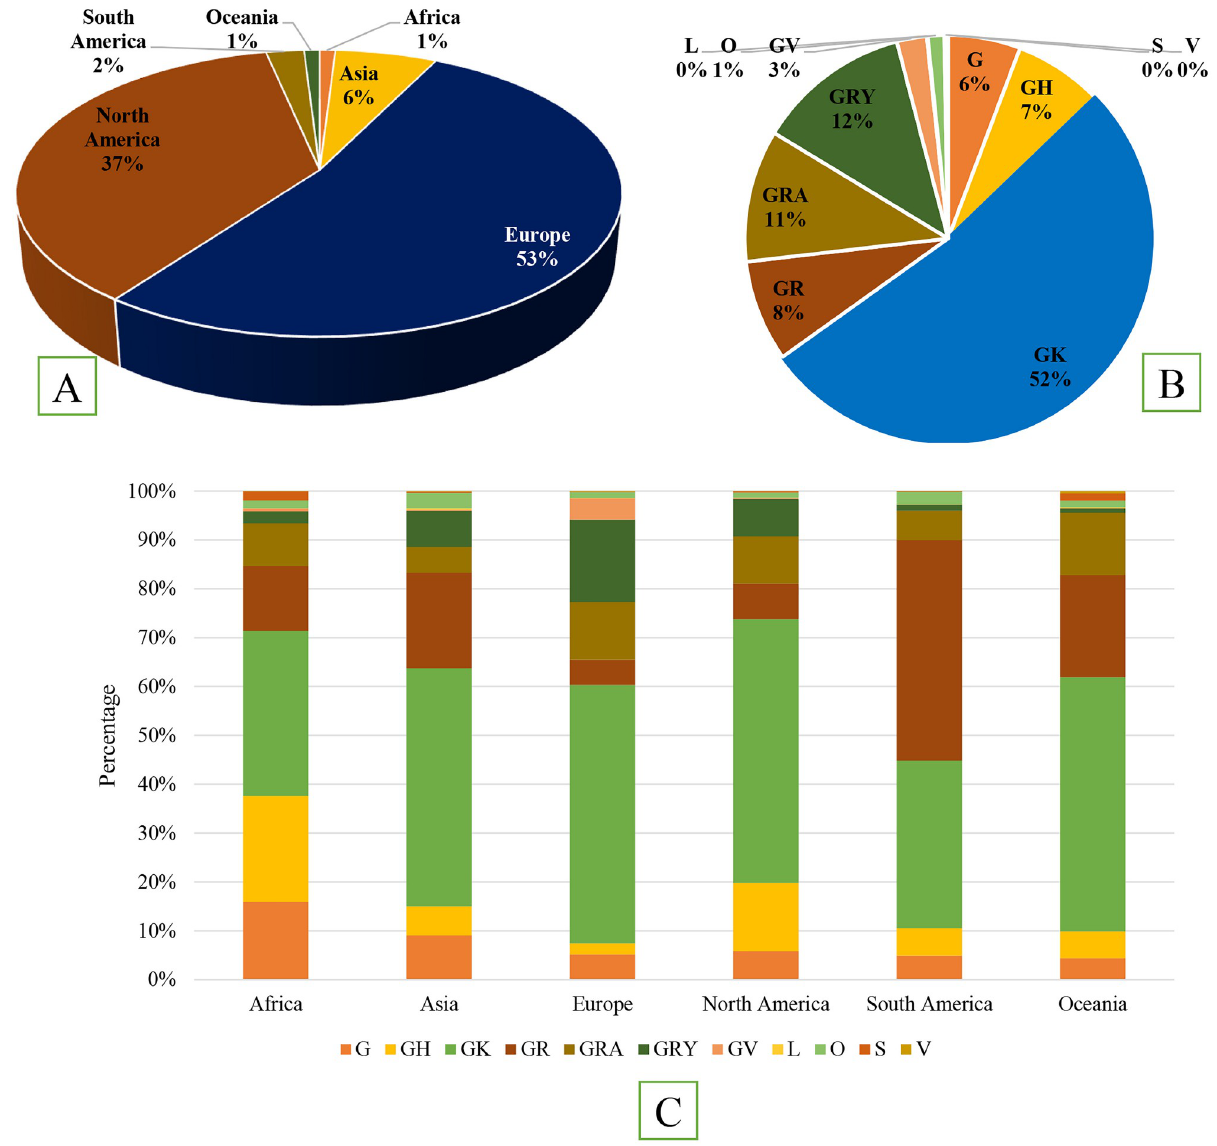
Fig 1. (A) Frequency distribution of total of 7540558 whole genome of SARS-CoV-2 among six continents. All of the whole genomes were collected and submitted to GISAID and NCBI during December, 2019 to January, 2022. Only genome sequences of high coverage of reference and complete genome were included in this analysis. (B) Frequency distribution of 7540558 whole genome of SARS-CoV-2 into eleven clades isolated during December, 2019 to January, 2022. (C) Distribution of eleven clades of 7540558 whole genome of SARS-CoV-2 in six